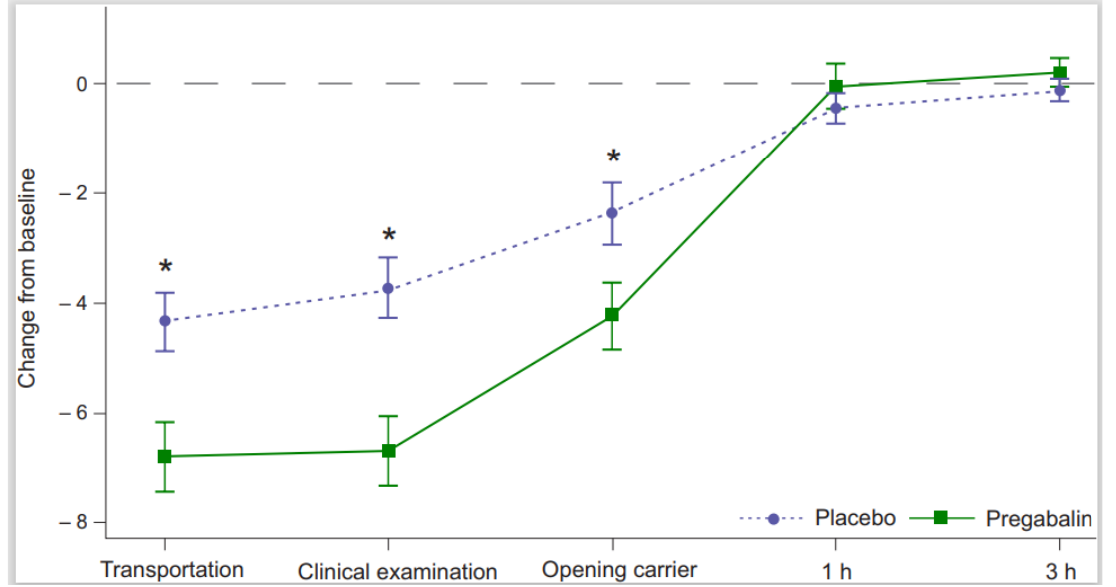
Figure 3. Mean (±SEM) change from baseline in the sum of signs of anxiety and/or fear during trans- portation, clinical examination, at home when opening the carrier, and 1 and 3 h after coming home. * Indicates a statistically significant difference between pregabalin 5 mg/kg and placebo treatments.